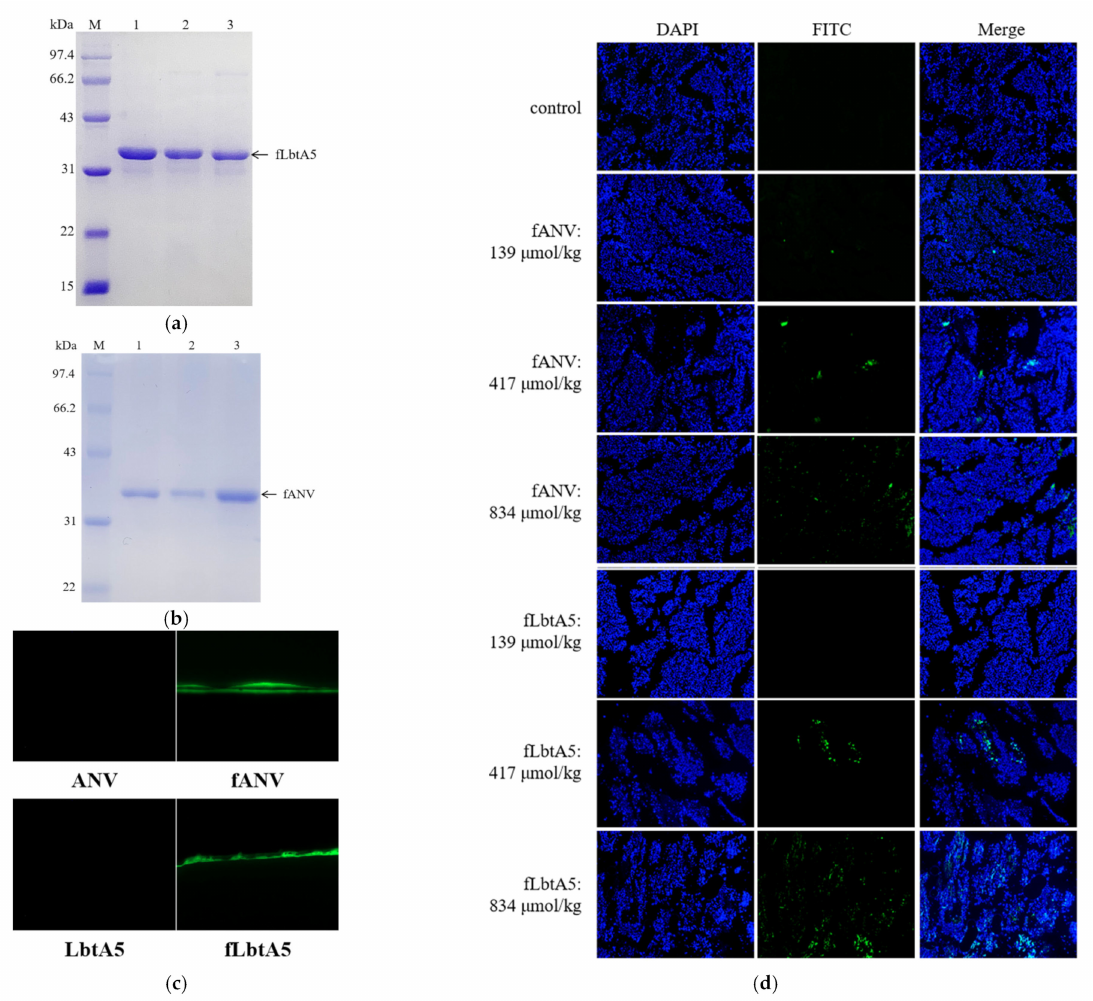
Figure 7. ANV and LbtA5 targeted tumor vessels. ( a ) Purified FITC-LbtA5 (40.68 kDa); ( b ) Purified FITC-ANV (36.28 kDa); ( c ) Fluorescence observation of FITC-labeled target proteins. FITC excitation wavelength: 488 nm; ( d ) FITC-ANV and FITC-LbtA5 were injected intravenously into mice bearing B16F10 solid tumors. Mice were sacrificed 30 min after tail vein injection, and tumor tissues were removed for section preparation. The control is the tumor tissue of the PBS group mice, which was excited at a 488 nm wavelength, and the fluorescence distribution was observed by inverted fluorescence microscope at 100 ×